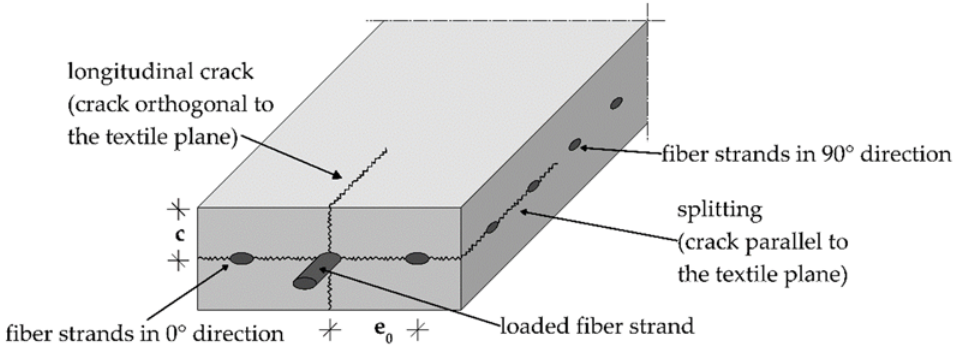
Figure 3. Overview of the types of cracking along a fiber strand of a textile.